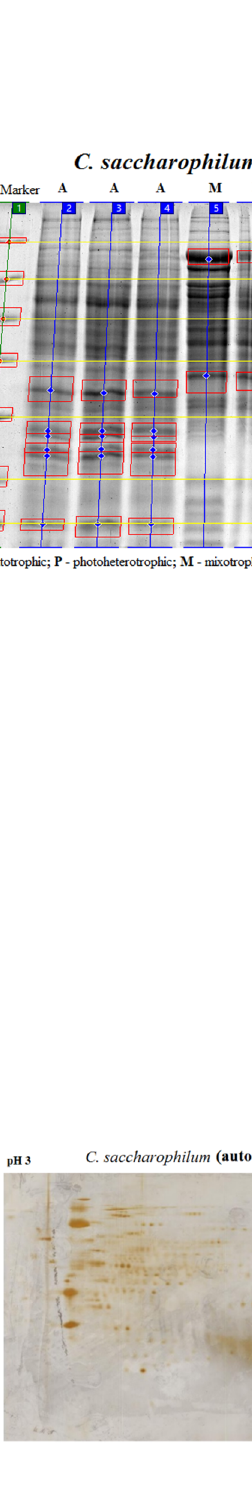
Figure 5. Representative 2-DE silver staining protein maps of C. sorokiniana , C. saccharophilum , and C. vulgaris cells.